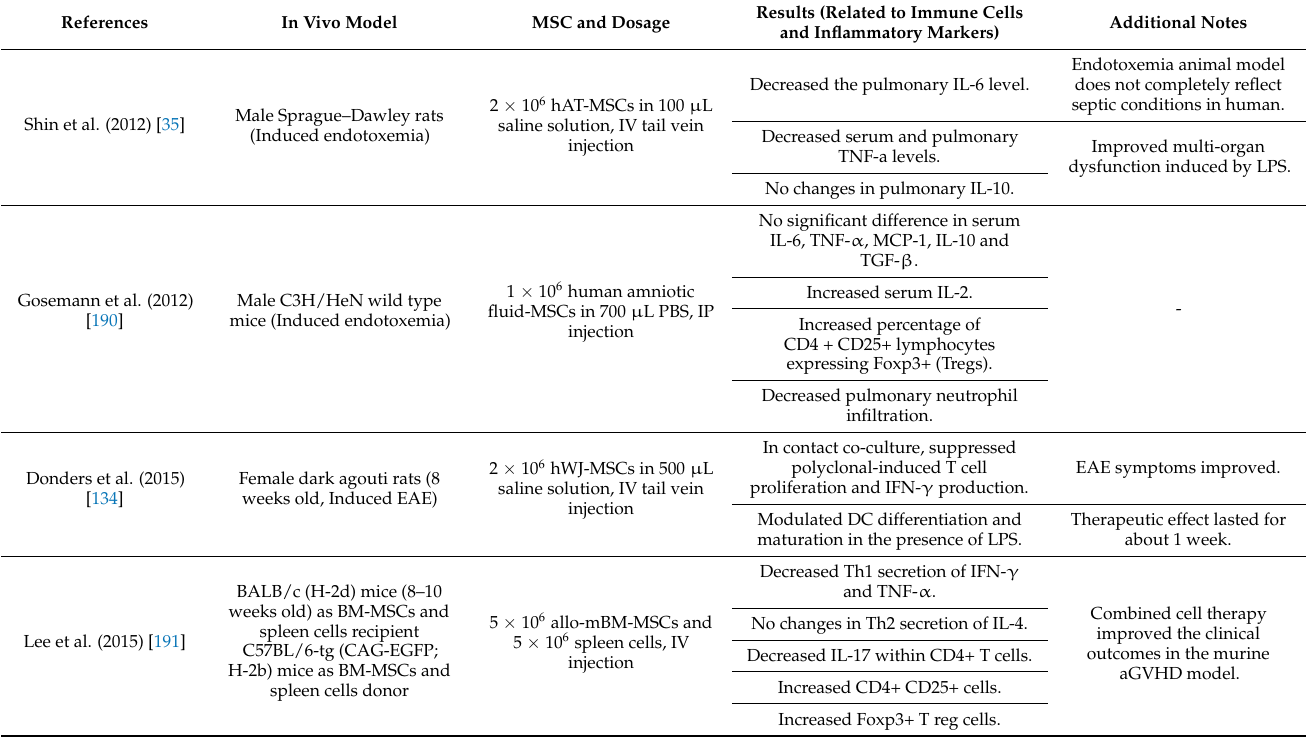
Table 4. A summary of in vivo studies of MSC effects on the pathological immune system from